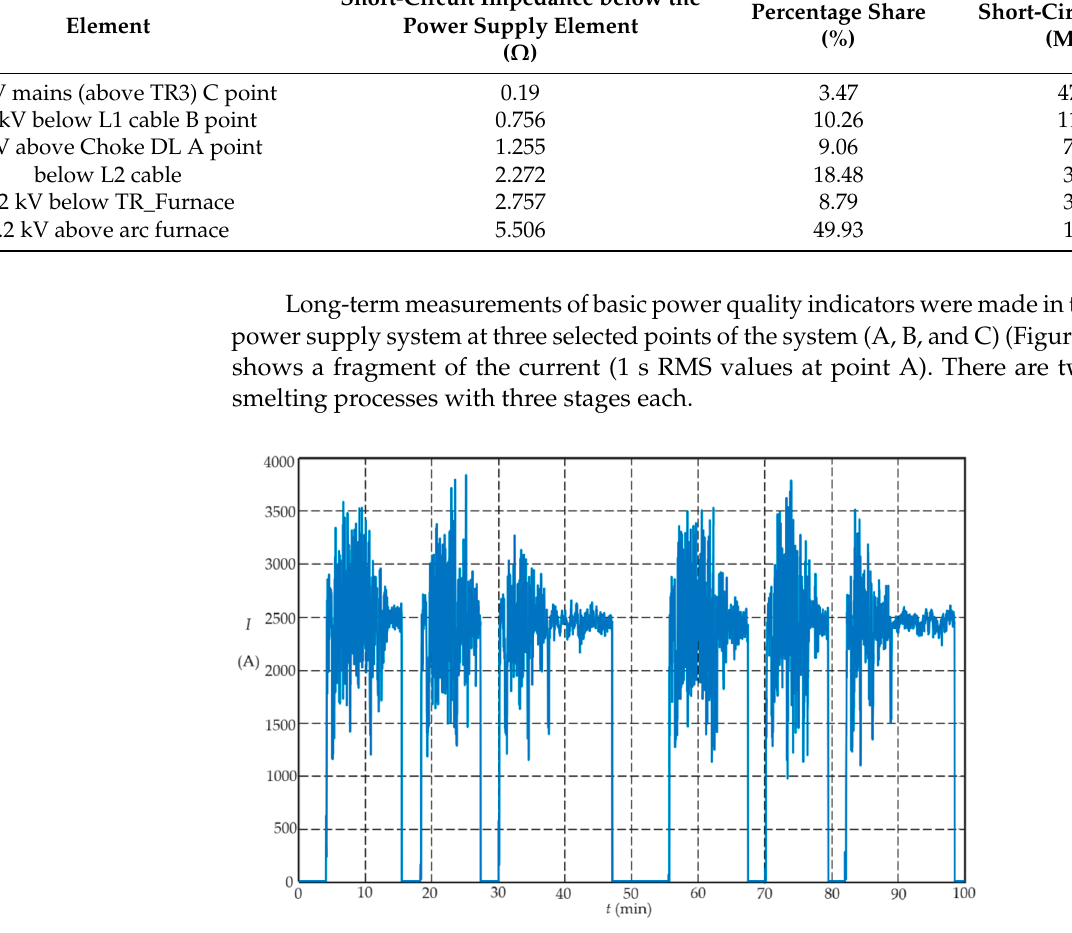
Table 1. Calculated values of impedance and short-circuit power in relation to the voltage of 30 kV. Short-Circuit Impedance below the Element